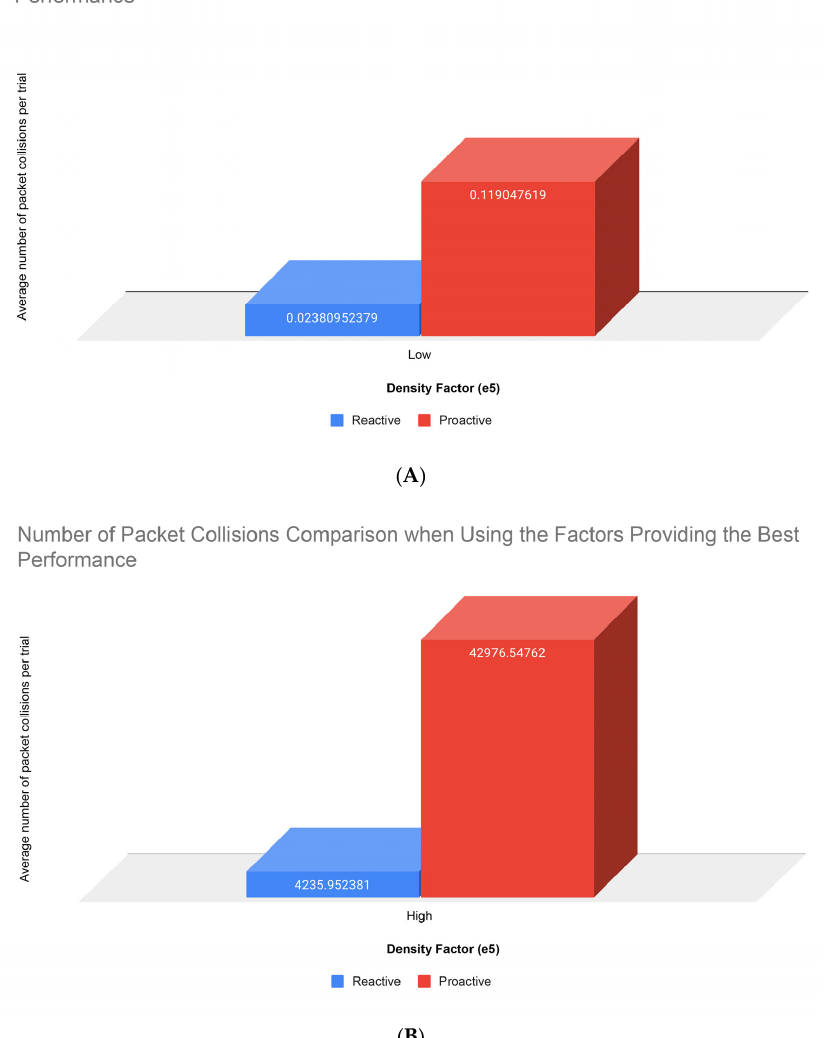
Figure 5. Comparison of the average number of collisions in the best scenario from the factors results of a proactive and reactive routing approach in IoST with the density factor (e5). ( A ) Low node density; ( B ) high node density.